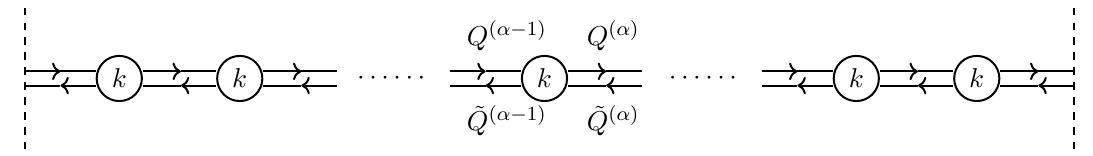
Figure 3 . The circular N = 2 superconformal quiver. Each of the N nodes denotes an SU( k ) N = 2 vector multiplet. The links are N = 1 bifundamental chiral multiplets. The dashed perpendicular lines at the left and right ends are